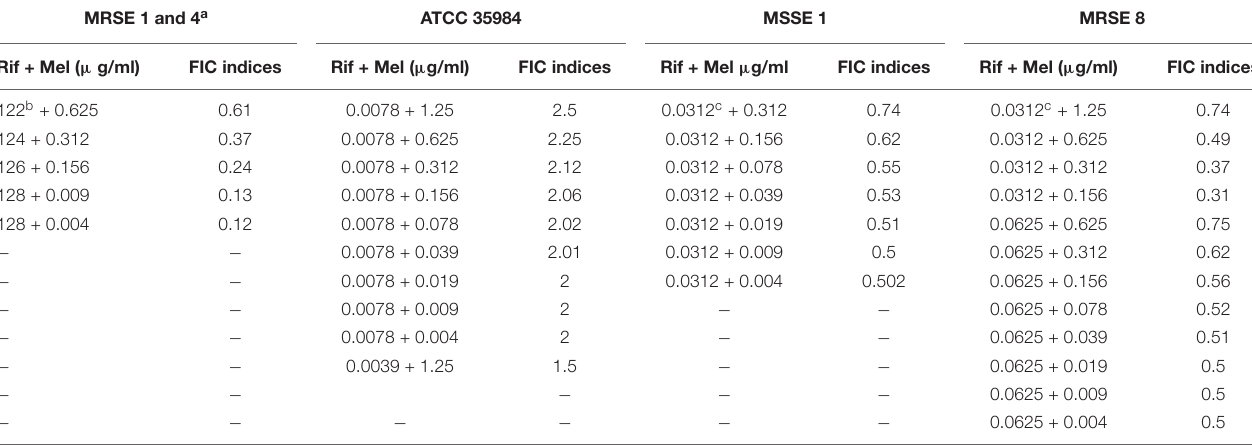
TABLE 3 | The best synergistic concentrations of Rifampin-Melittin based on MIC against selected isolates. MRSE 1 and 4